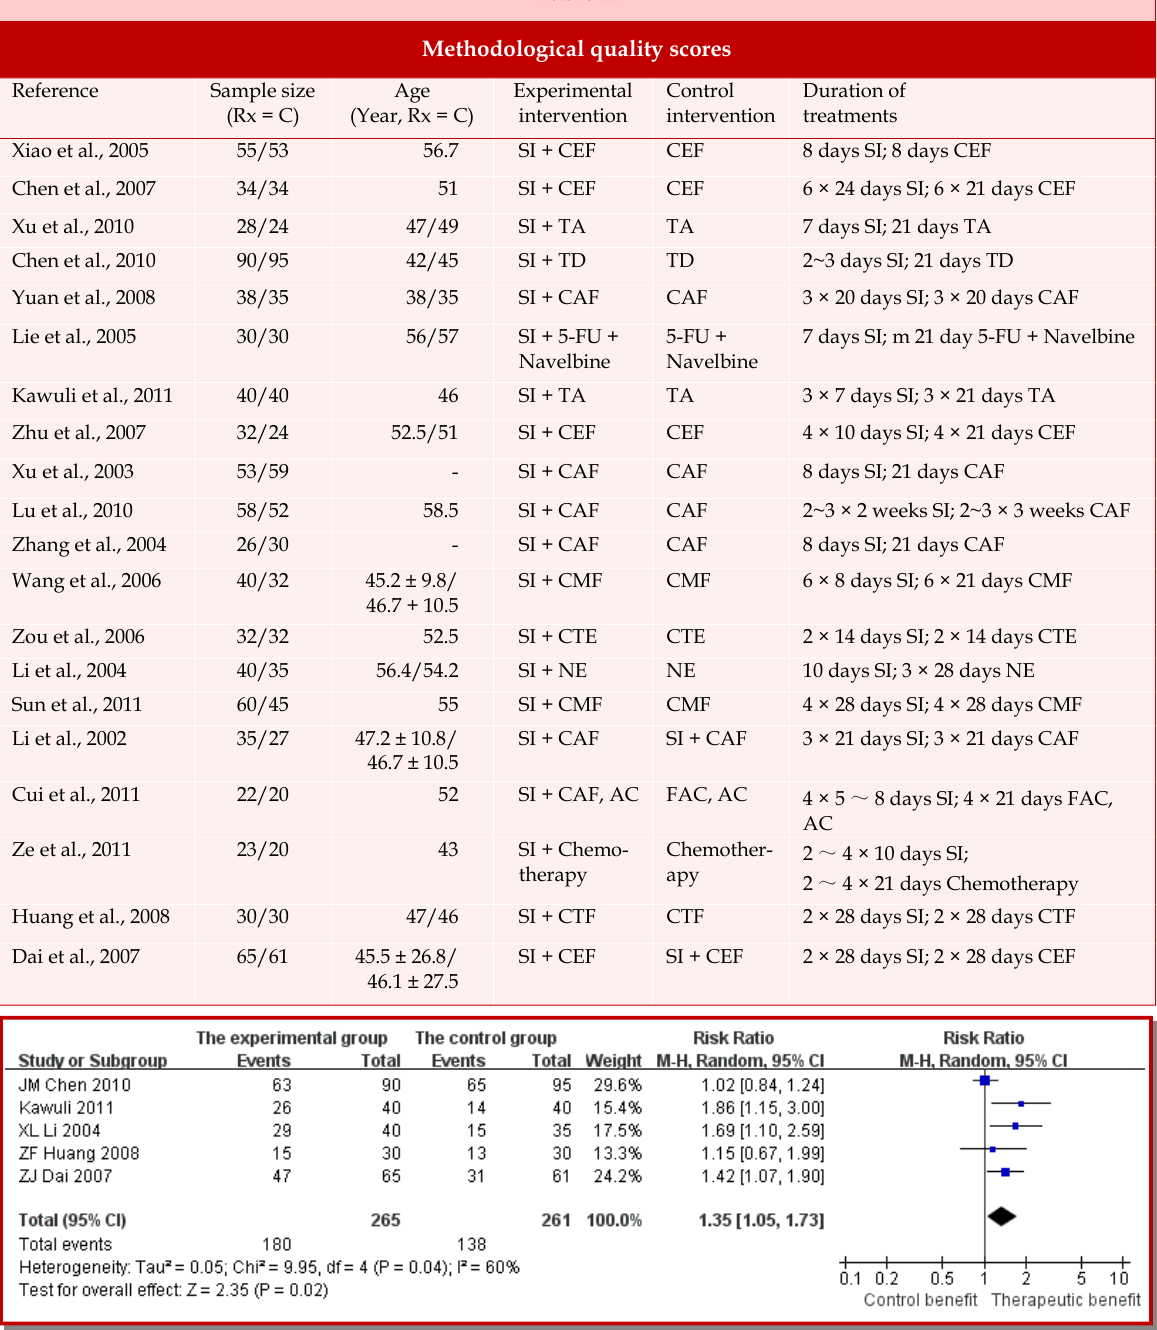
Figure 2: Treatment efficiency of SI in treatment of breast cancer with